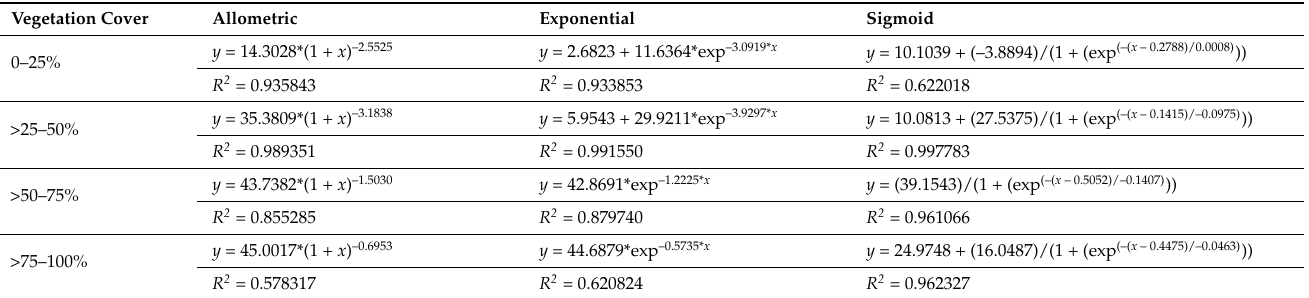
Figure 3. Fitting curves between volumetric soil organic carbon (SOC) density (kg C/m 3 ) and soil depth using three functions in ten sites of sabkhas with different vegetation covers along the southern Red Sea coast of Saudi Arabia. F Vegetation cover = 1032.8 ***; F Depth = 45.6 ***; F Vegetation cover x Depth = 2.9 ***; F -values represent the two-way analysis of variance (ANOVA); ***: p < 0.001. Table 3. Model parameters and fitting results of volumetric soil organic carbon (SOC) density (kg C/m 3 ) using three functions in ten sites of sabkhas with different vegetation covers along the southern Red Sea coast of Saudi